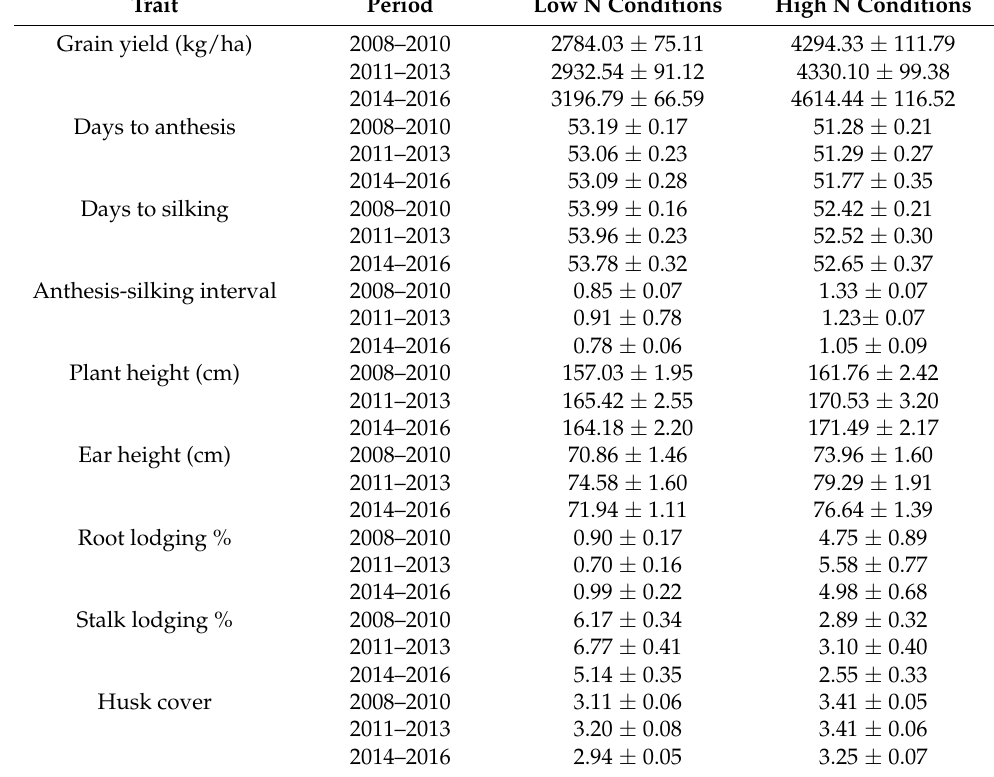
Table 2. Grain yield and other agronomic traits of eighteen early-maturing maize hybrids of three breeding periods under low N in four environments and high N in five environments in Nigeria from 2017 to